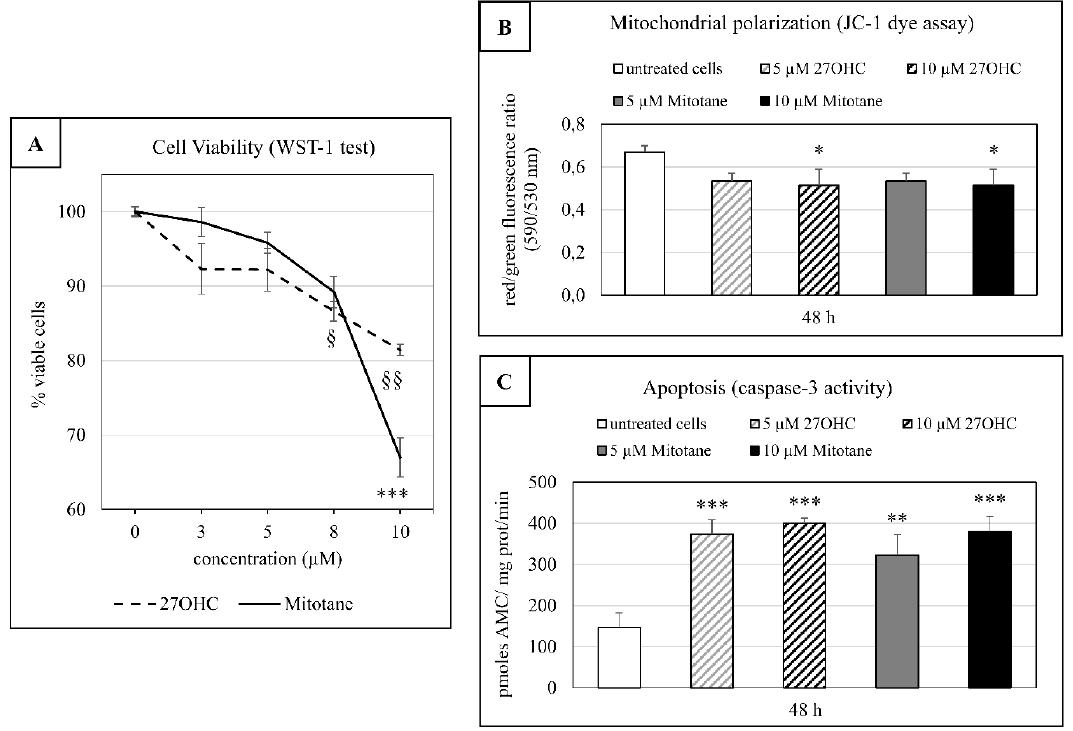
Figure 2. Effect of 27-hydroxycholesterol and mitotane on H295R cell viability and apoptosis. ( A ) Cells were treated for 48 h with increasing concentrations of 27OHC or mitotane (0–10 µM). For the WST-1 test see Methods 2.4. Data are reported as means ± SD from three independent experiments and expressed as % of viable cells compared to control (untreated cells): § p < 0.05, §§ p < 0.01, *** p < 0.001. ( B ) Mitochondrial polarization state in H295R cells treated with 5 or 10 µM 27OHC or with 5 or 10 µM mitotane for 48h. For the JC-1 assay see Methods 2.5. Data are means ± S.D. of three different experiments. Significantly different versus untreated cells: * p < 0.05. ( C ) Caspase-3 specific activity in H295R cells treated with 5 or 10 µM 27OHC or mitotane for 48h. AMC: 7-amino-4-methylcoumarin (see Methods 2.6.). Data are means ± S.D. of three different experiments. Significantly different versus untreated cells: ** p < 0.01, *** p < 0.001.